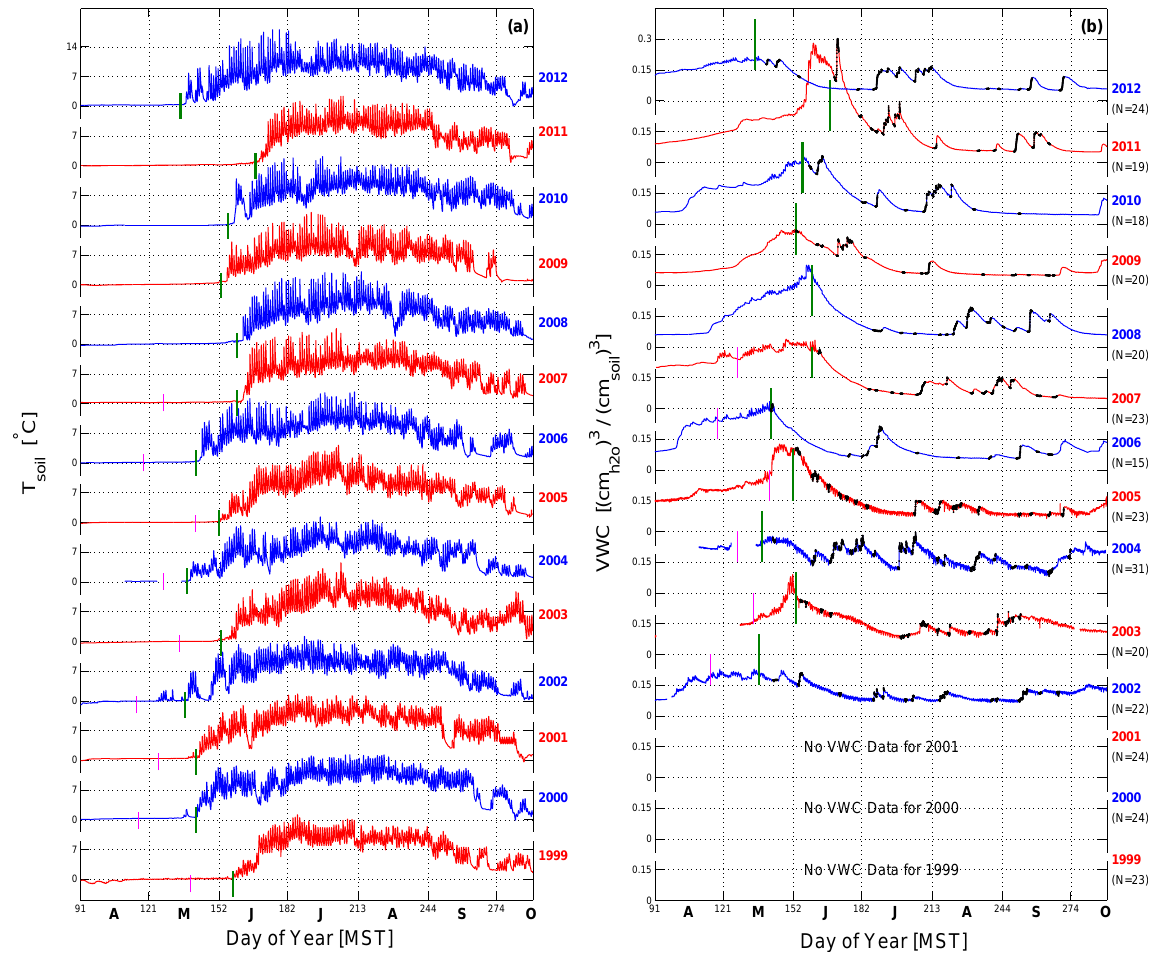
Figure 1. (a) Soil temperature and (b) soil moisture for years 1999 to 2012. In (b) , the black dots indicate wet days and the number of wet days for each year is shown to the right of the panel underneath the year. The warm-season start date was chosen based on the date that the soil temperature diurnal changes started to occur as indicated by the vertical green lines. The vertical mauve lines for years 1999–2007 are the start date of the growing season as determined by Hu et al. (2010a). Starting with year 2006, a single set of soil sensors at a depth of 5cm were used (see AppendixA1 for